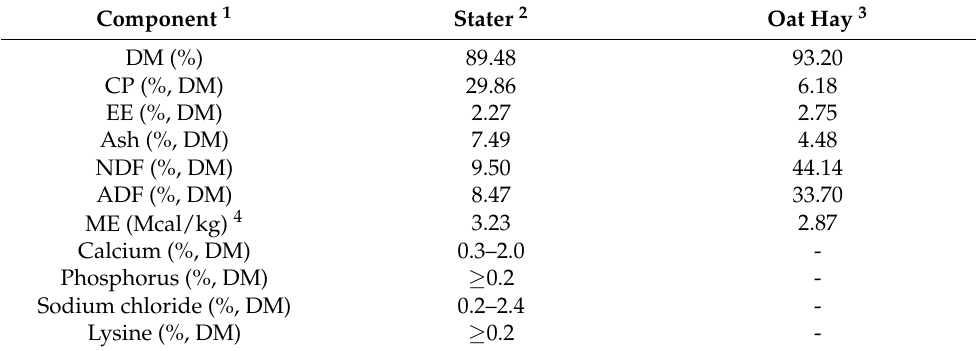
Table 7. Ingredient and chemical composition (as % of DM) of calf starter and oat hay. Component